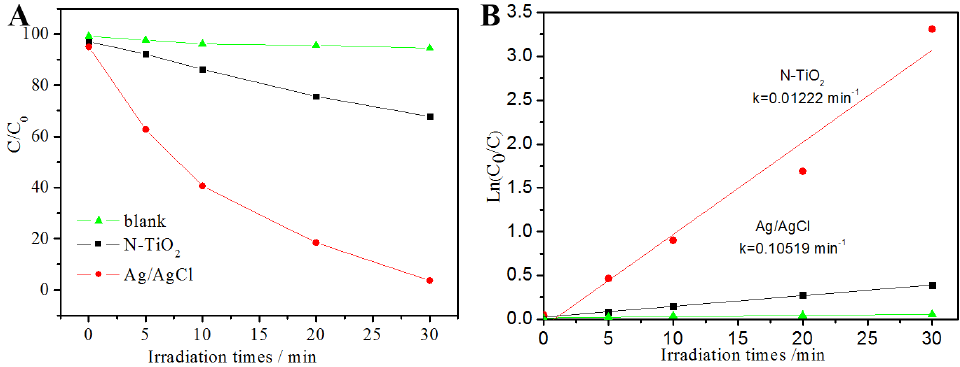
Figure 6. ( A ) Photodecomposition and rate of photodecomposition of RhB dyes over Ag/AgCl composites, N-TiO 2 and ( B ) the blank experiment without